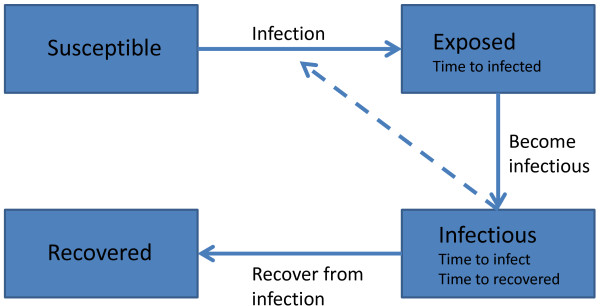
Schematic of the Agent Based Monte Carlo simulations corresponding to Table1.